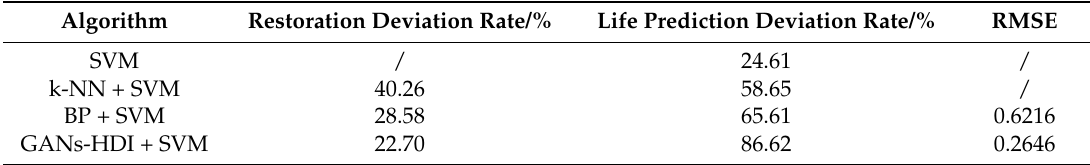
Table 6. Performance comparison on heterogeneous datasets for intelligent power distribution and